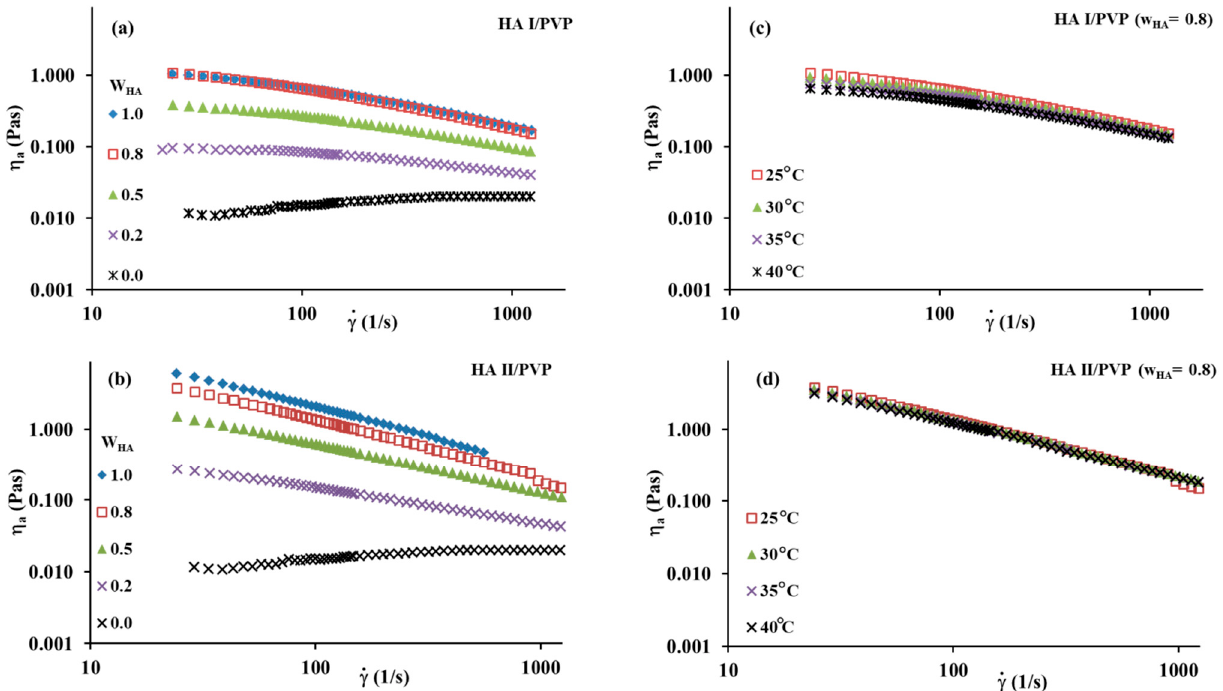
Figure 2. ( a ) and ( b ) Plots of apparent shear viscosity 𝜂 (cid:3028) vs. shear rate γ(cid:4662) of HA and PVP and HA/PVP blends at 25 °C; ( c ) . γ and ( d ) plots of apparent shear viscosity 𝜂 (cid:3028) vs. shear rate γ(cid:4662) of a HA/PVP (w HA = 0.8) blend for temperatures ranging from of apparent shear viscosity η a vs. shear rate of a HA/PVP (w HA = 0.8) blend for temperatures ranging from 25 ◦ C to 40 ◦ 25 °C to 40 °C.